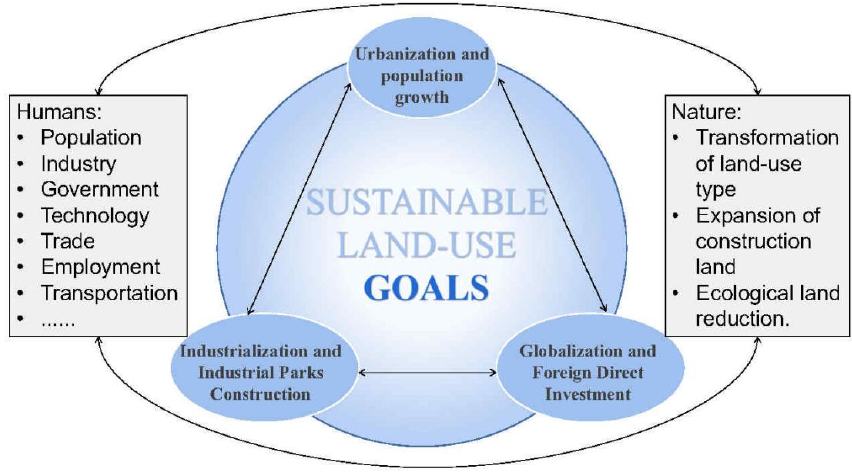
Figure 10. Coupling mechanism of globalization, urbanization and industrialization.